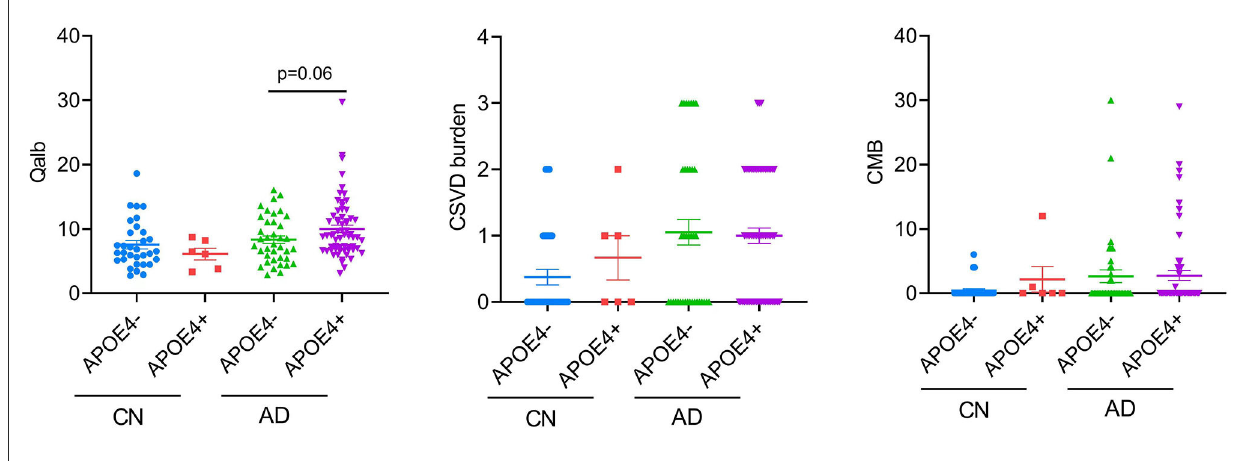
FIGURE5 APOE4 effects on BBB function and CSVD severity. Each dot represents a single